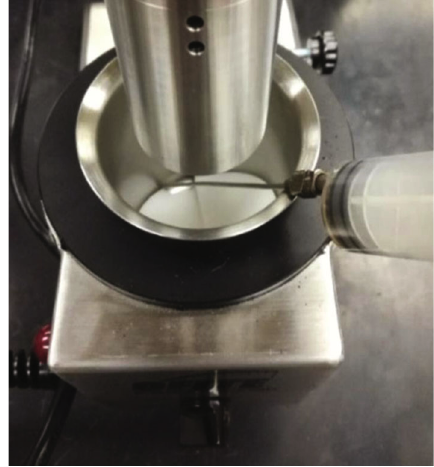
Figure 2: Setup of dynamic sag